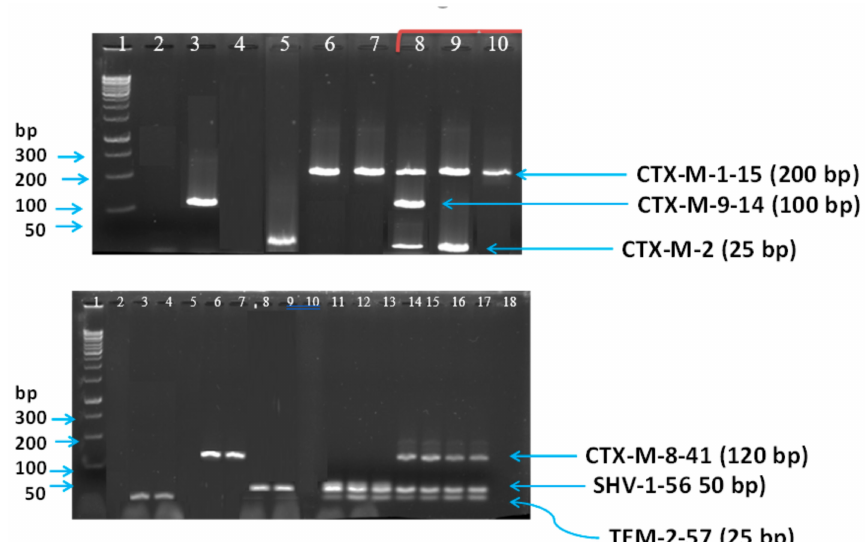
Figure1. IllustrativemultiplexPCR bla CTX-M (CTX-M-1-15includingCTX-M-1, CTX-M-3andCTX-M-15; CTX-M-2 including CTX-M-2; CTX-M-9-14 including CTX-M-9 and CTX-M-14), bla TEM / bla TEM / bla SHV including TEM variants (TEM-1 and TEM-2), SHV-1-56 (SHV-1, SHV-2 and SHV-56) and CTX-M-8-41 (CTX-M-8, CTX-M-25, CTX-M-26 and CTX-M-39 to CTX-M-41). Top panel: Lanes 1, DNA ladder; 2, RNAse free sterile water; 3, isolate with CTX-M-9-14 ; 4, ESBL negative Escherichiacoli ATCC 25922; 5, isolate with CTX-M-2 ; 6–7, isolates with CTX-M-1-15 ; 8, isolate with CTX-M-1-15, CTX-M-9-14 , and CTX-M-2 ; 9, isolate with CTX-M-1-15 and CTX-M-2 ; 10, isolate with CTX-M-1-15 . Bottom panel Lanes 1, DNA ladder; 2, RNAse free sterile water; 3–4, isolates with TEM-2-57 ; 5, ESBL negative Escherichiacoli ATCC 25922; 6–7, isolate with CTX-M-8-41 ; 8–9, isolates with SHV-1-56 ; 10, isolate with none of the three genes; 11–12, isolates with SHV-1-56 and TEM-2-57 ; 13–17, isolates with CTX-M-8-41, SHV-1-56, and TEM-2-57 ; 18, ESBL negative Pseudomonas aeruginosa ATCC